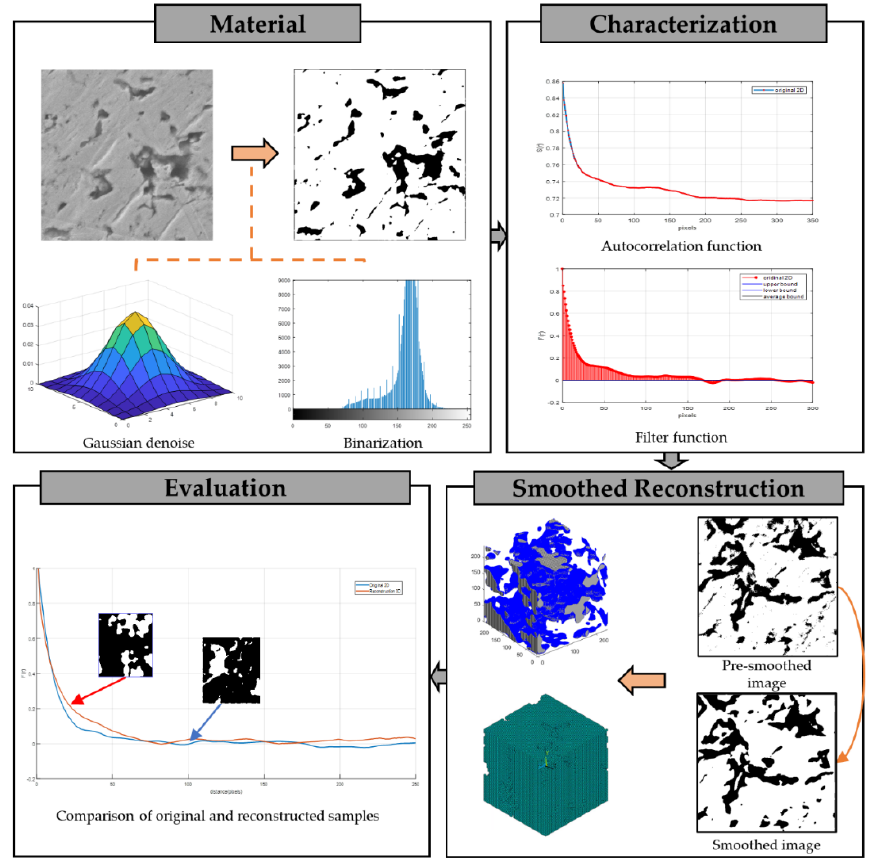
Figure 6. The Flow chart of reconstructing stochastically equivalent 3D morphology of sintered micron silver joints.